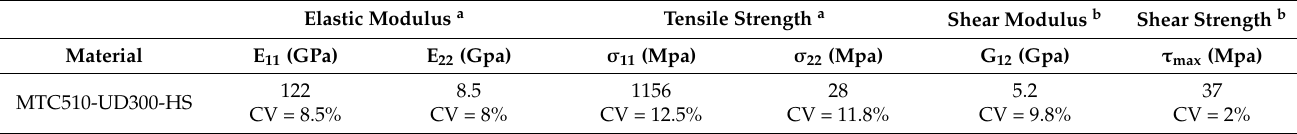
Table 1. Mechanical properties of the substrate.